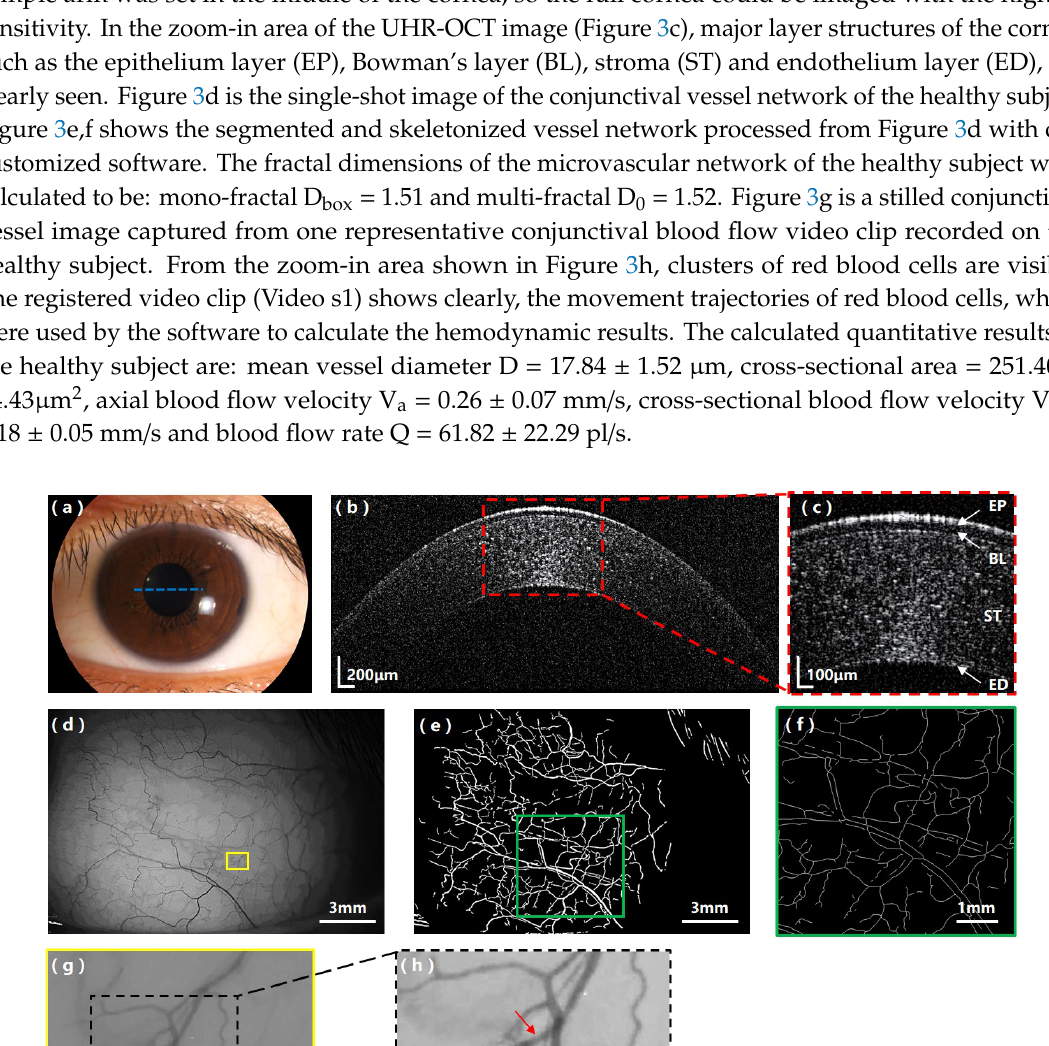
Figure 3. Experimental results on the healthy subject with the multi-modal anterior eye imager. (a) Appearance image of the healthy subject’s eye; the blue dashed line indicates the UHR-OCT scanning position. (b) UHR-OCT image of the health cornea and (c) the zoom-in area showing clear corneal layer structures. EP: epithelium layer, BL: Bowman’s layer, ST: stroma, ED: endothelium layer. (d) The bulbar conjunctival vessel network image of the healthy subject; the yellow box indicates the location where the representative video clip (Video s1) was taken. (e) The segmented vessel network image and (f) the skeletonized vessel network image of the selected region (green box) in (e). (g) A representative conjunctival vessel image captured from the bulbar conjunctival blood flow video clip (Video s1). (h) Zoom-in area of (g) showing the resolved clusters of red blood cells (red arrows).